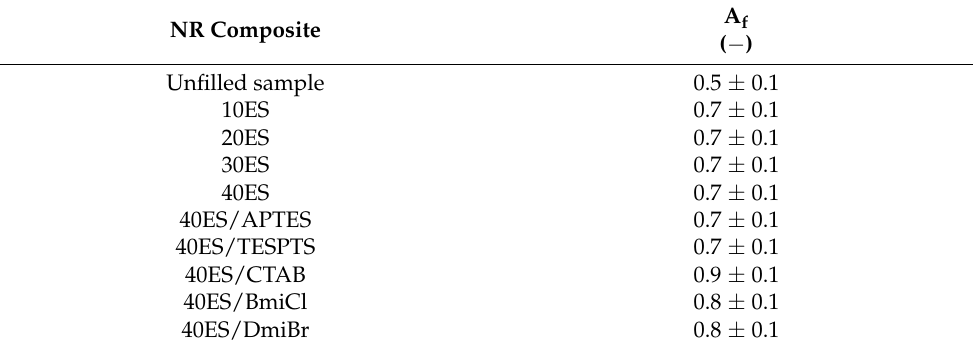
Table 8. Thermo-oxidative aging factor (A f ) of NR